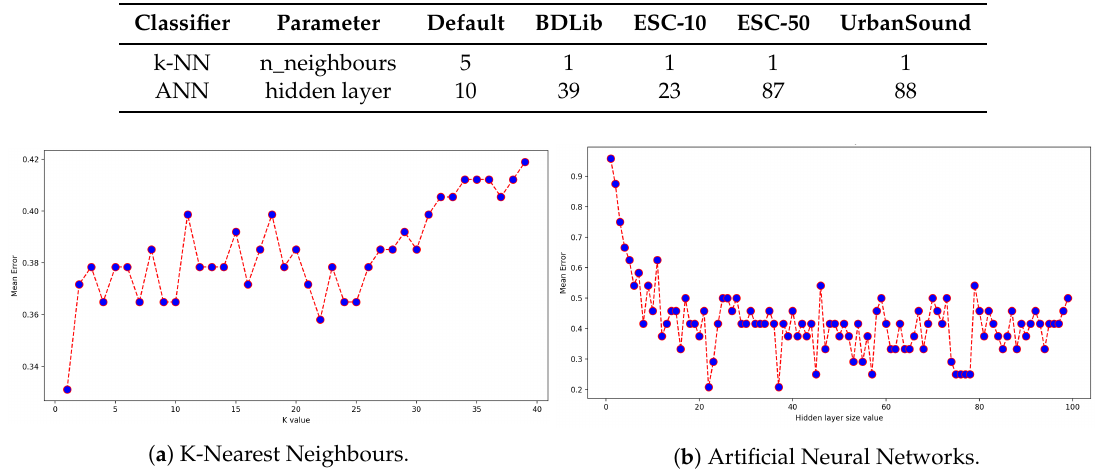
Figure 4. The configuration of the sound classifier is selected based on the achieved accuracy. Table 5. Optimal values of the classifiers’ parameters which minimize the accuracy error per dataset.